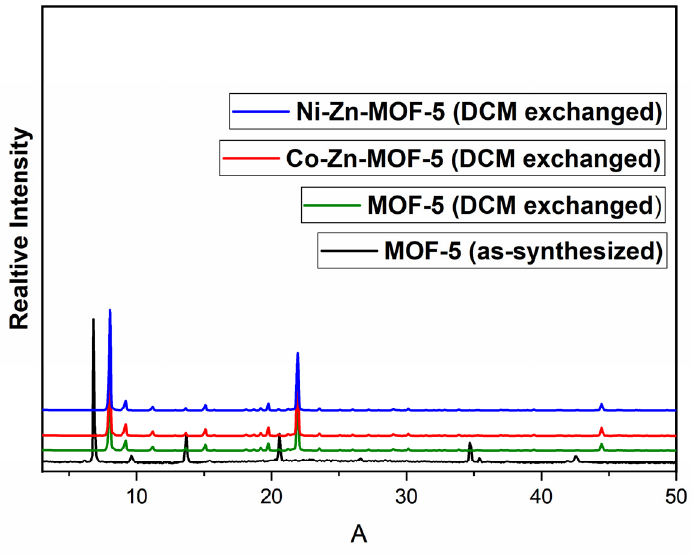
Figure 4. PXRD patterns of the as-synthesized (MOF-5) and DCM-exchanged (MOF-5 and M-MOF- 5) samples.